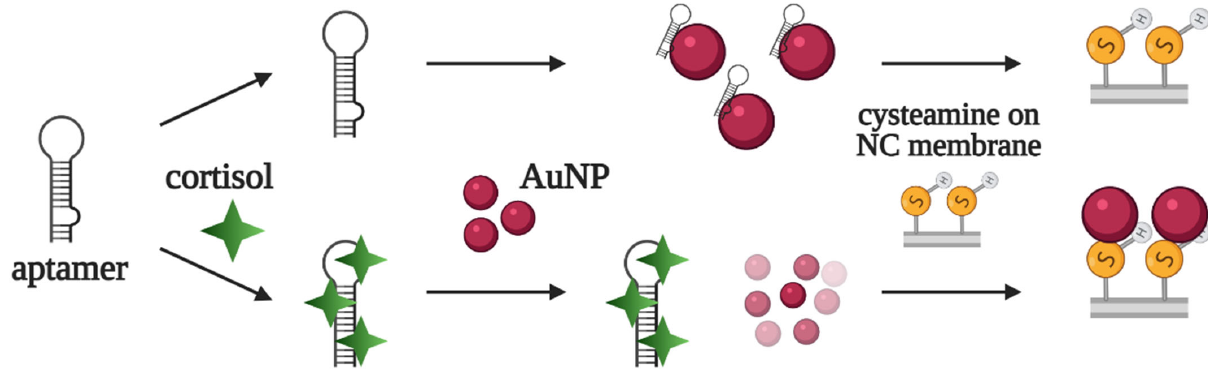
Figure 8. Aptamer-based lateral flow assay for cortisol detection developed in [45]. In the presence of cortisol, the aptamer binds to its target, while unbound AuNPs interact with membrane-bound cysteamine, resulting in red line formation. Without cortisol, the aptamer is adsorbed on AuNPs and prevents their interaction with cysteamine; thus, the membrane remains colorless.